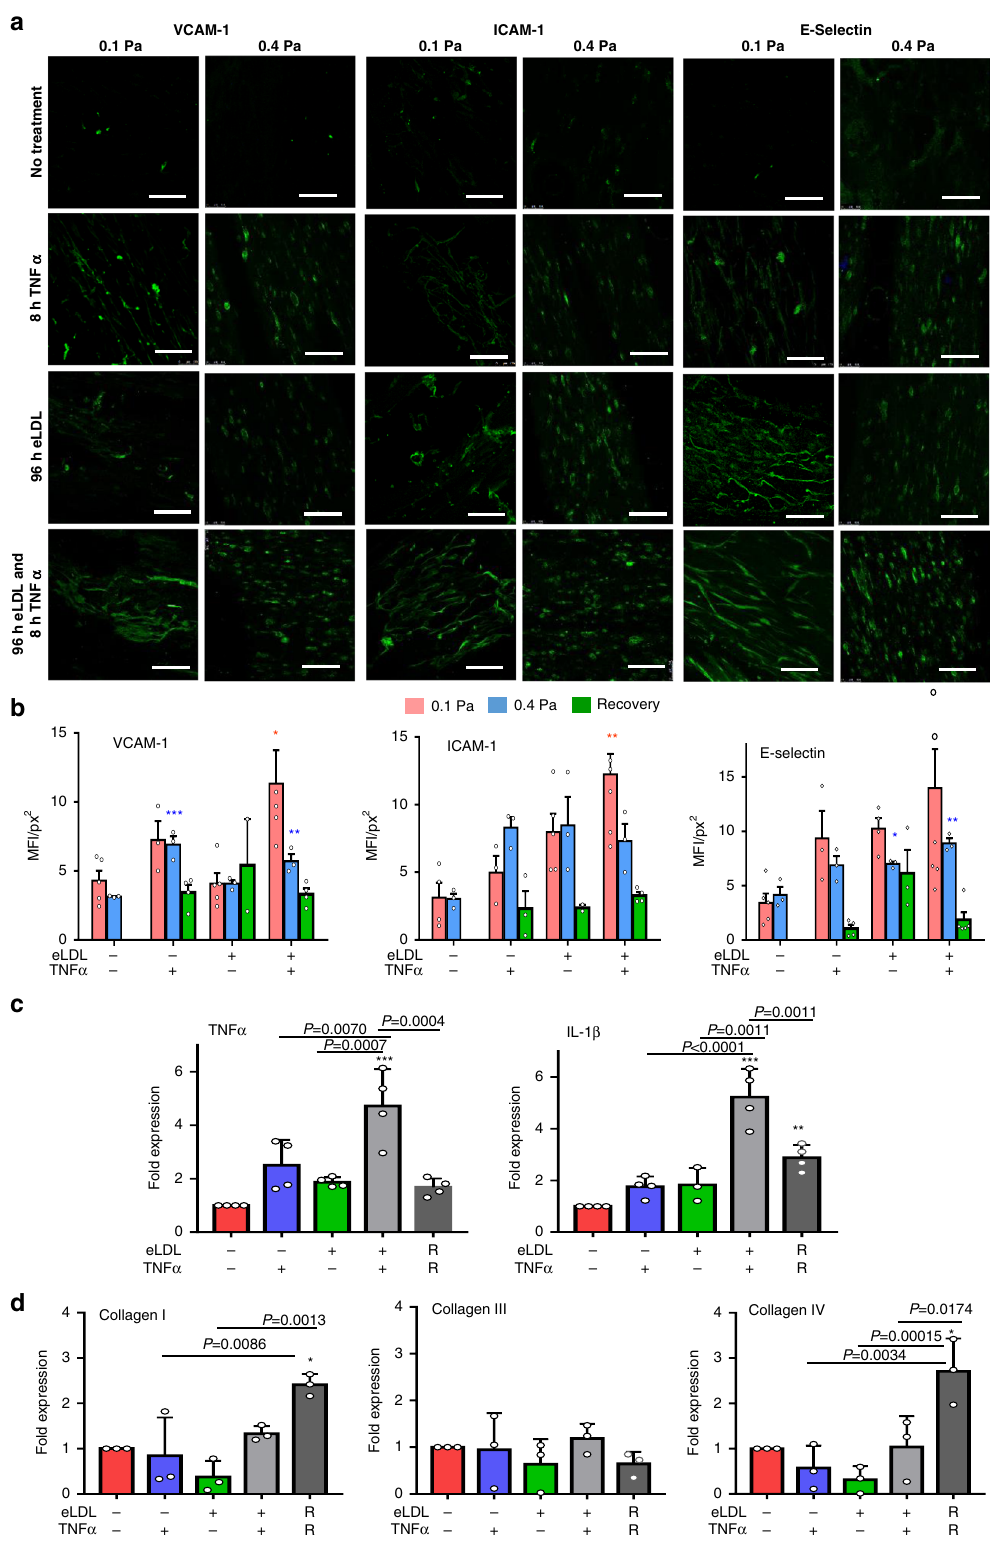
and both combined had differential effects on CD80 expression (Fig. 7a, b). Expression of CD36, an important scavenger receptor is greatly increased in the treatment groups (Fig. 7a, b). This receptor present on monocytes and macrophages has an important function in lipid uptake and foam cell formation 55,56 .